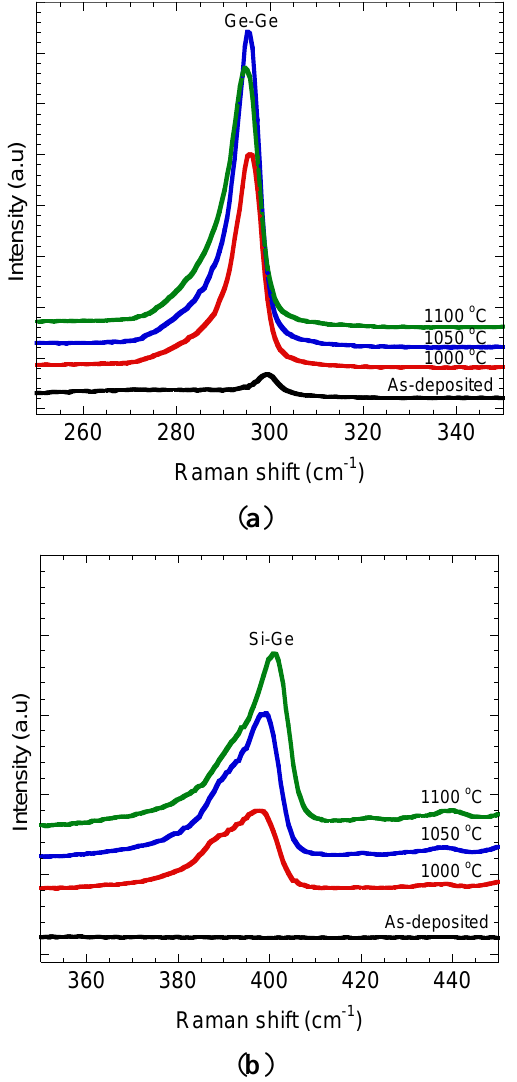
Figure 4. Enlarged Raman spectra in the range of ( a ) Ge-Ge mode and ( b ) Si-Ge mode.